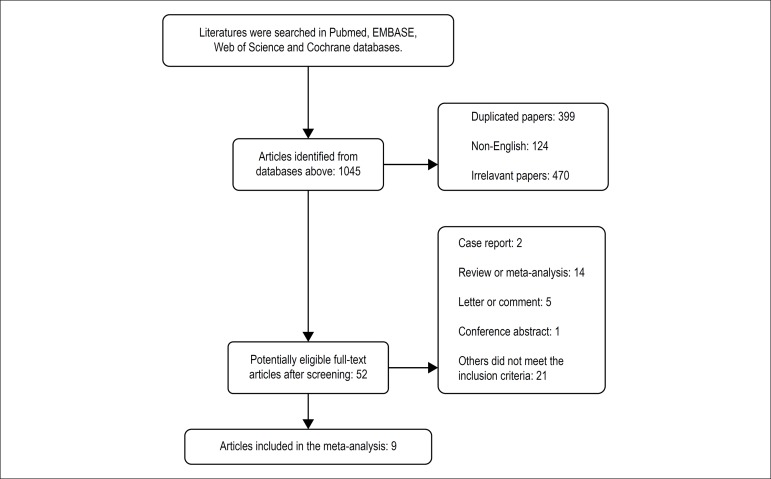
Flow diagram shows the process of literature selection.